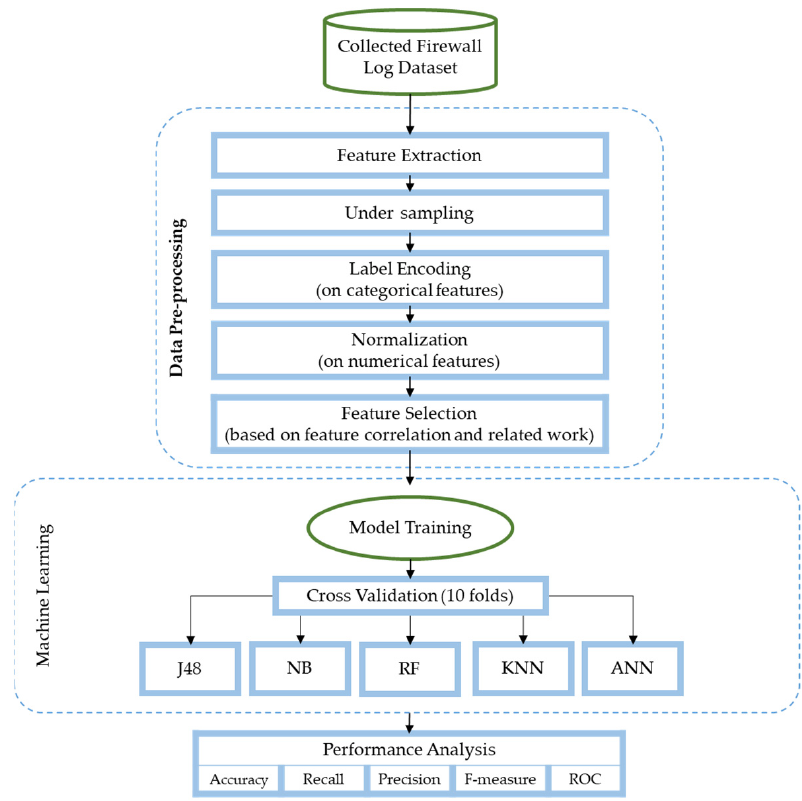
Figure 1. Research methodology